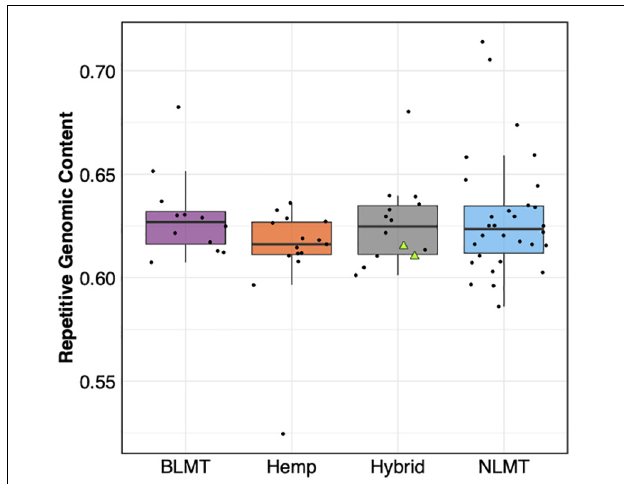
FIGURE 6 | Repetitive Genomic content. The estimated repetitive genomic content by group which does not differ significantly between groups. The two NIDA samples are presented within the hybrid grouping by two green